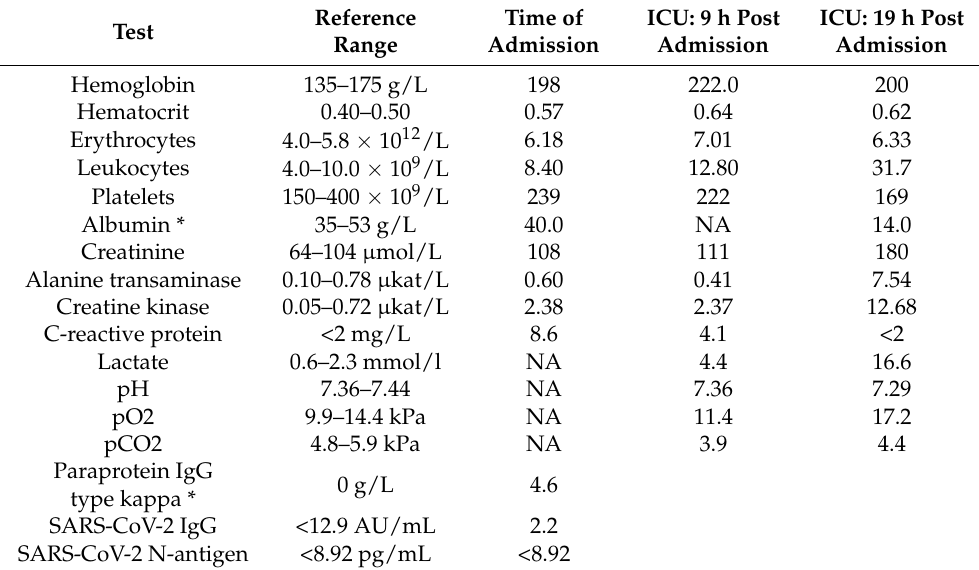
Table 1. Laboratory values during admission in a patient with rapid progression of COVID-19- associated capillary leak